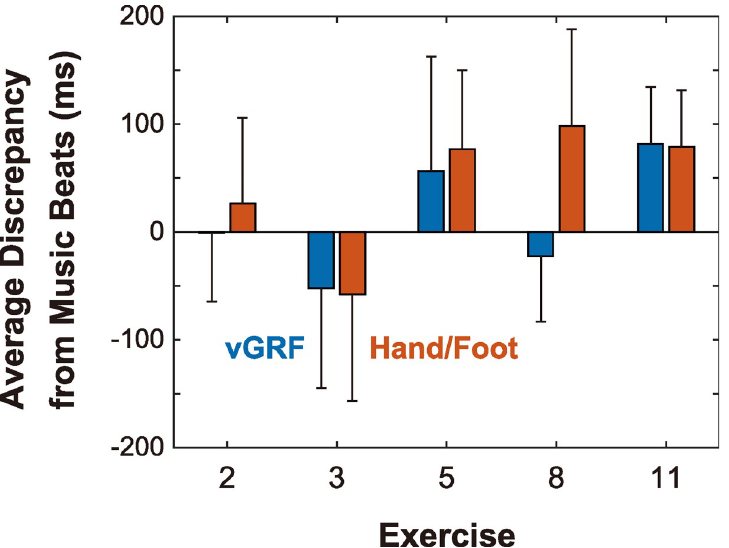
Fig 8. Temporal displacement between peak vGRF, movement feature points, and music beats. This figure shows the average temporal displacement between vGRF peaks and music beats and that between the feature points of hand/ foot motion and music beats. Error bars represent the standard